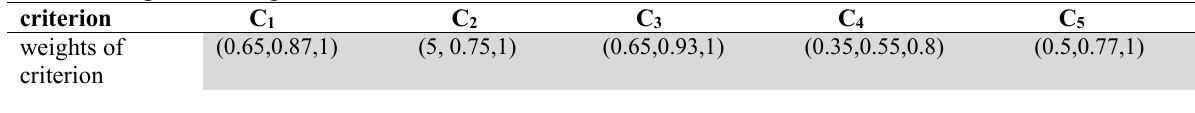
Results of general weights of criteria (cid:2205)(cid:3557) criterion C